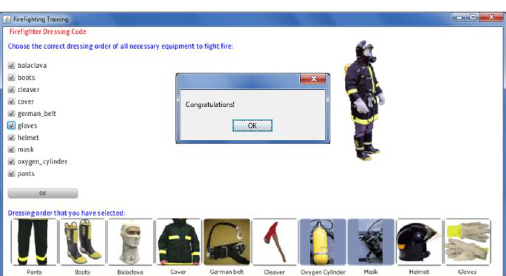
Figure 8. 2D interface for firefighter training in workstation.